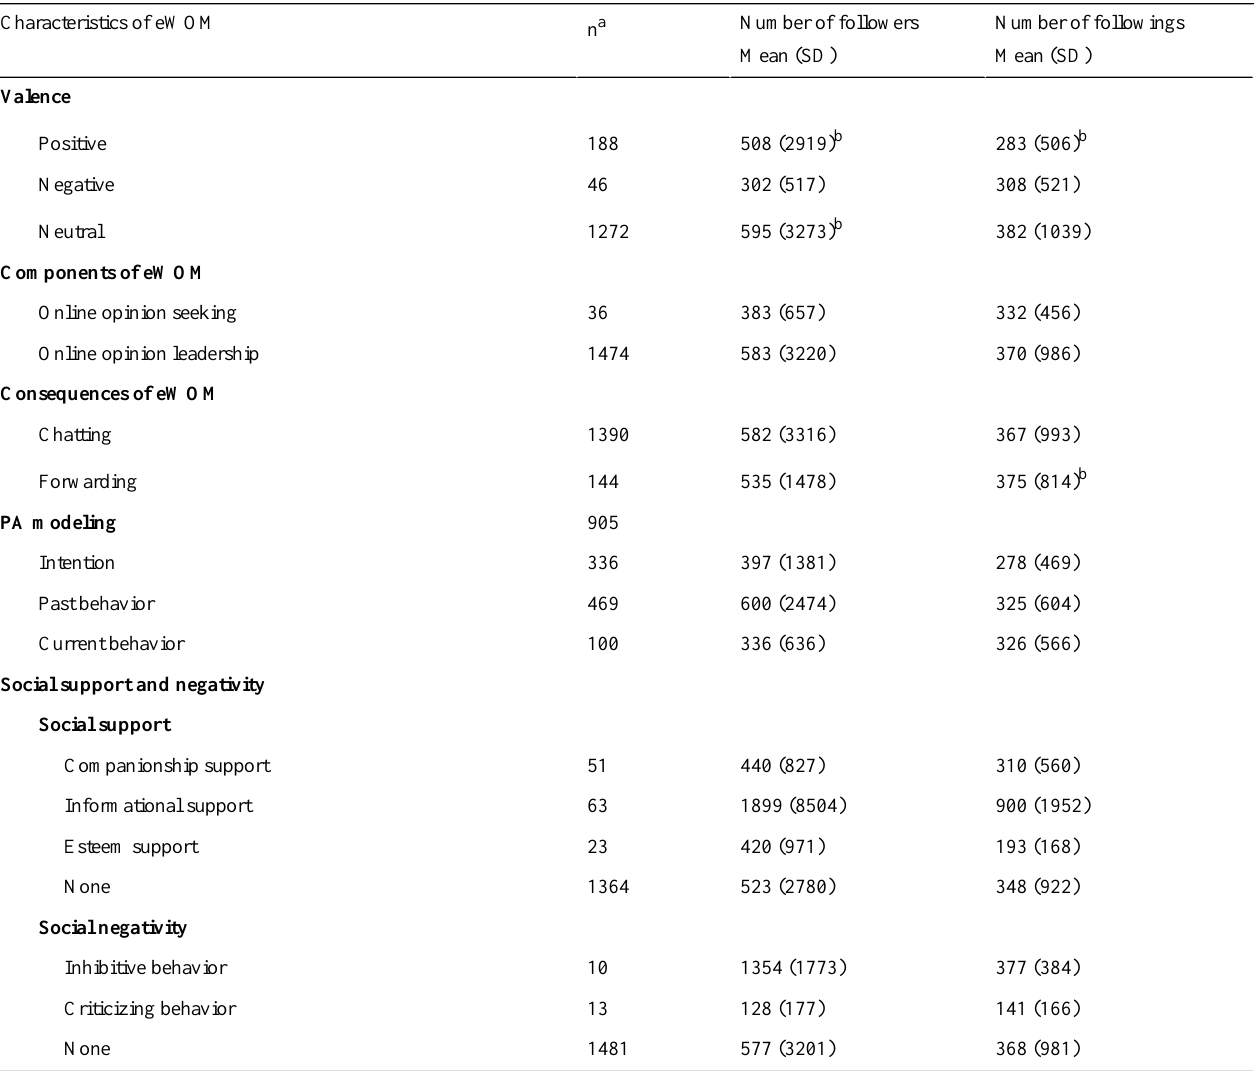
Table 2. Descriptive electronic word of mouth (eWOM) characteristics of tweets about physical activity (PA).